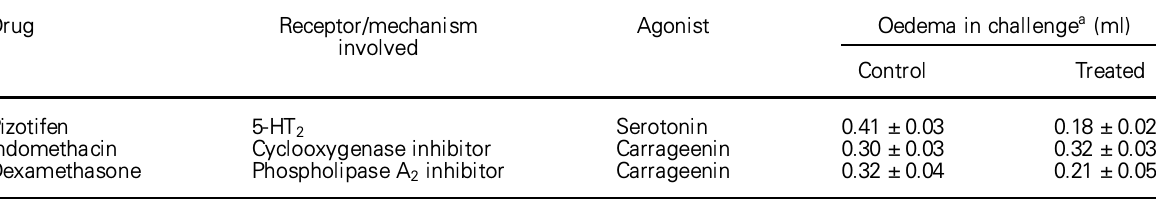
Table 3. Local effect of pizotifen, indomethacin and dexamethasone on oedema induced by SEA challenge of rat paws Drug